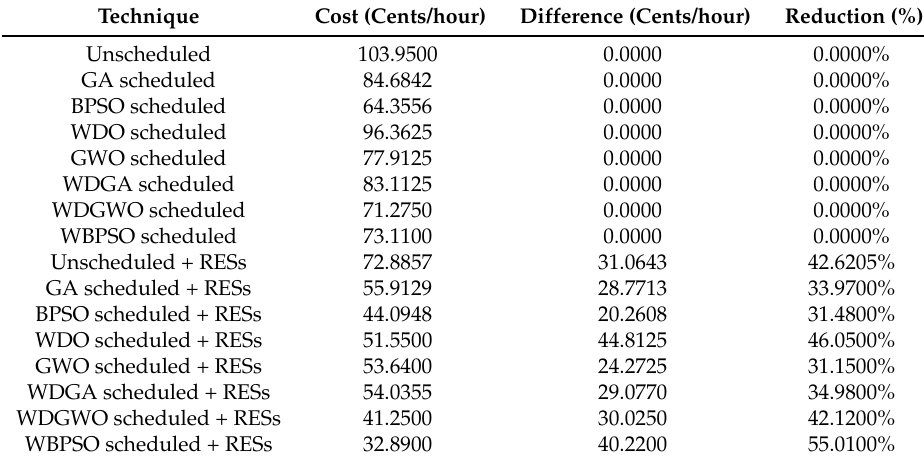
Table 12. Hourly cost with and without RESs.